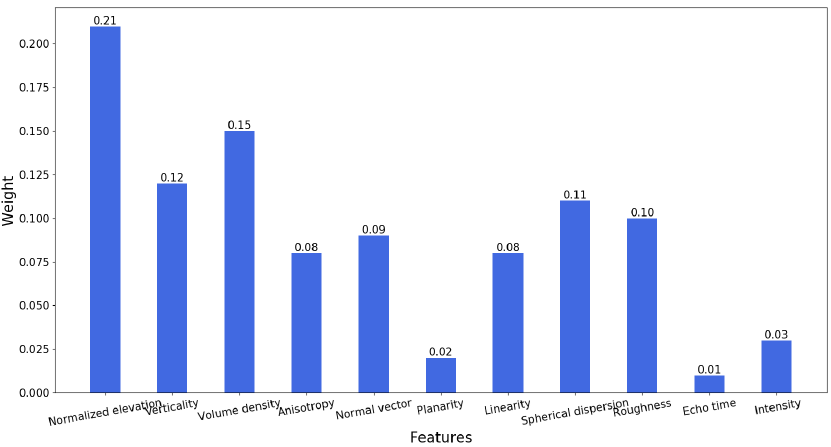
Figure 10. Feature weight evaluation.